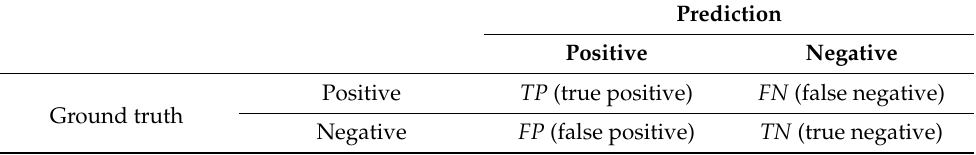
Table 7. Details of TP , FP , FN , and TN